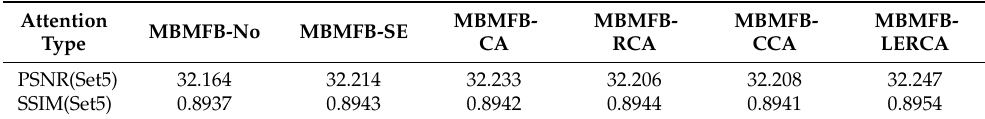
Table 2. Performance comparison of various attention mechanisms in basic blocks.